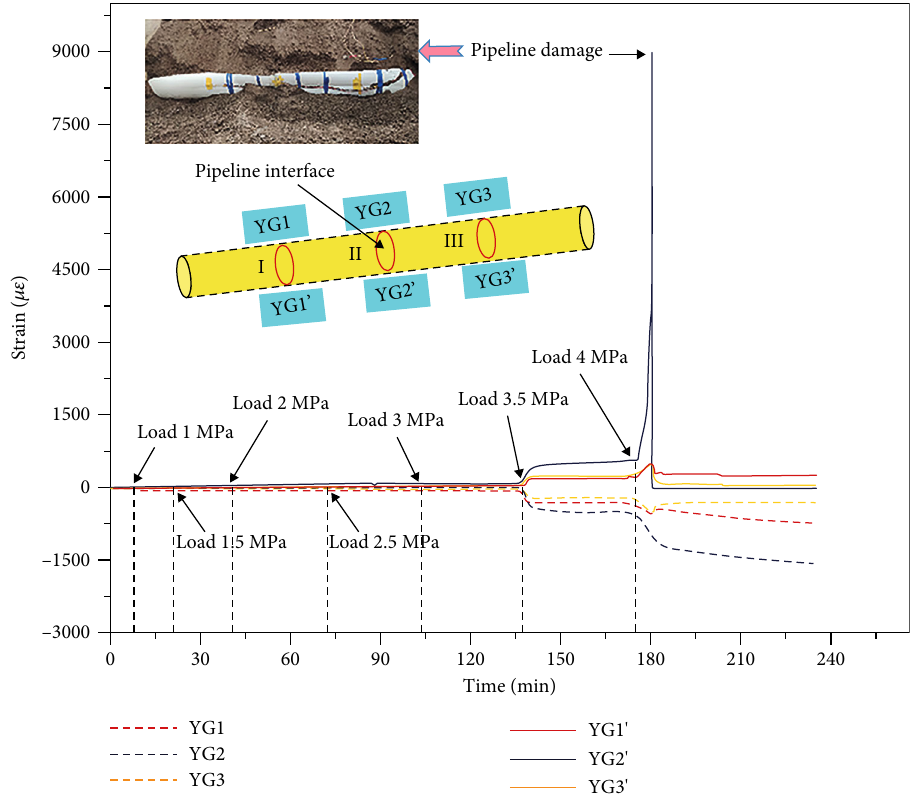
Figure 14: Strain time history curves of measuring points at di ff erent sections of